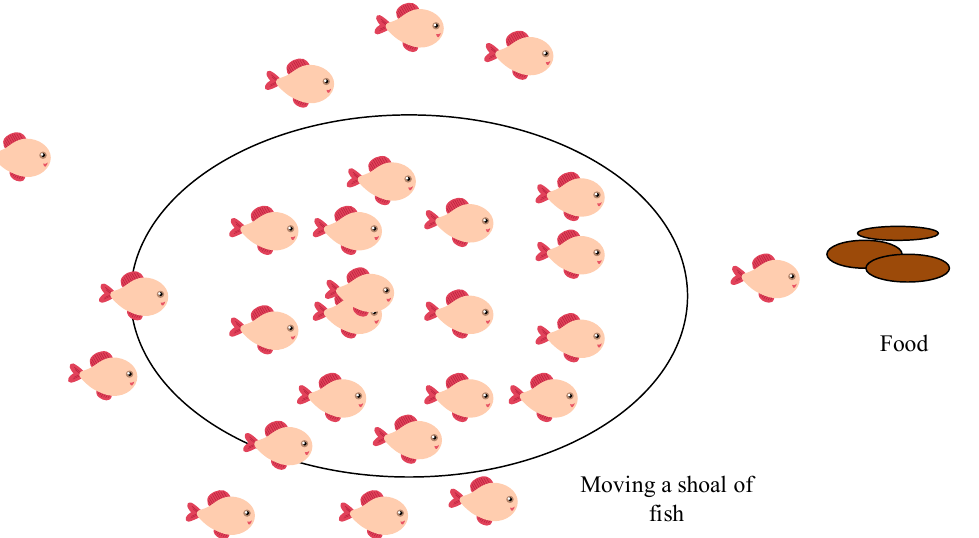
Figure 3. The principle of the fish swarm algorithm.